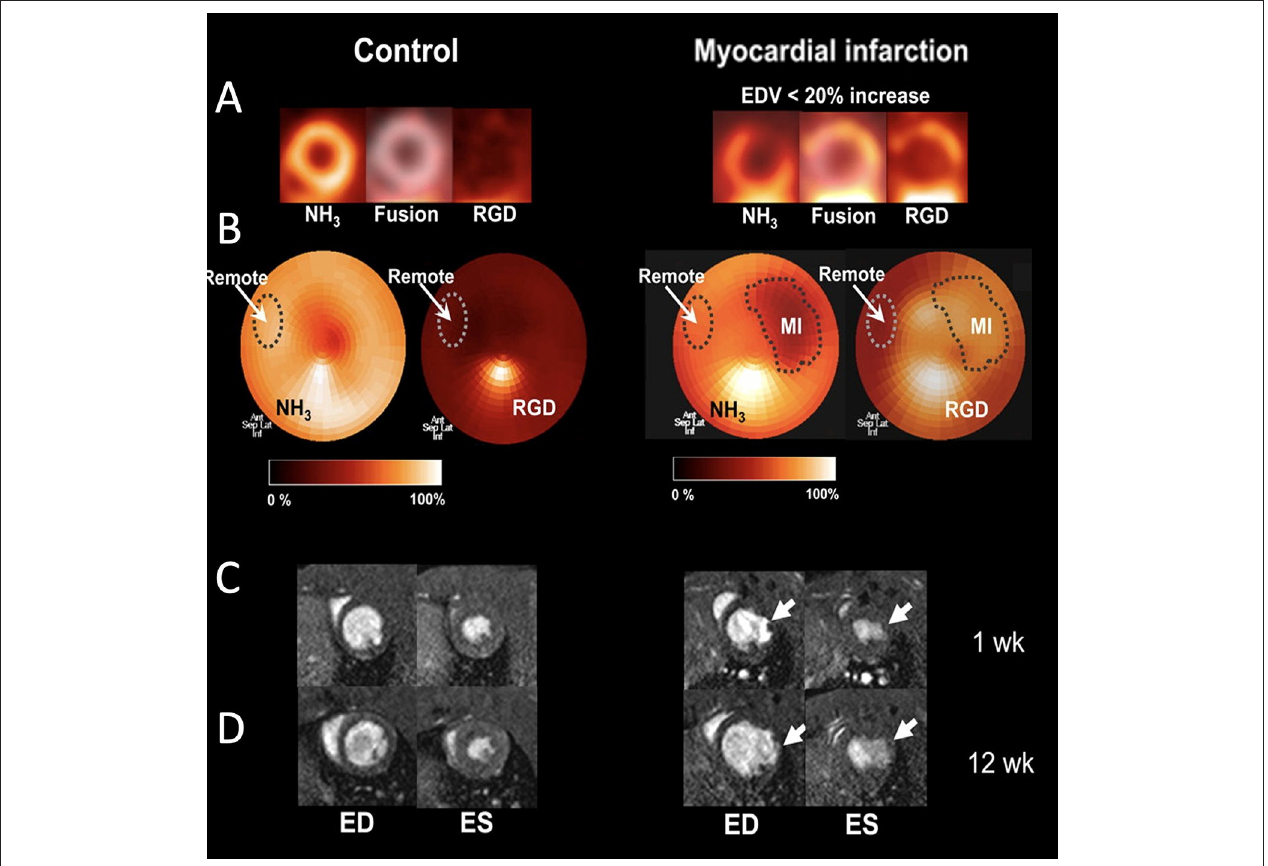
FIGURE 6 | Imaging of angiogenesis in myocardial infarction (MI). (A) PET images of control rats and rats after MI (right), which show separate and fused co-registered NH 3 and 18 F-RGD tomograms. (B) NH 3 polar maps and co-registered 18 F-RGD polar maps. Each NH 3 polar map was normalized to its corresponding remote myocardium uptake and defect area region of interest (ROI) was defined using 50% threshold. Subsequently, remote and defect ROIs were co-registered in the 18 F-RGD polar map using same axes to evaluate 18 F-RGD uptake in infarcted and remote myocardium. (C) Representative cross-sectional MR images of the left ventricle (LV) during end-diastole (ED) and end-systole (ES) 1 week after MI. (D) Corresponding MR images of same rats 12 week after MI [adopted from ( 88)]. 18 F-RGD, 18